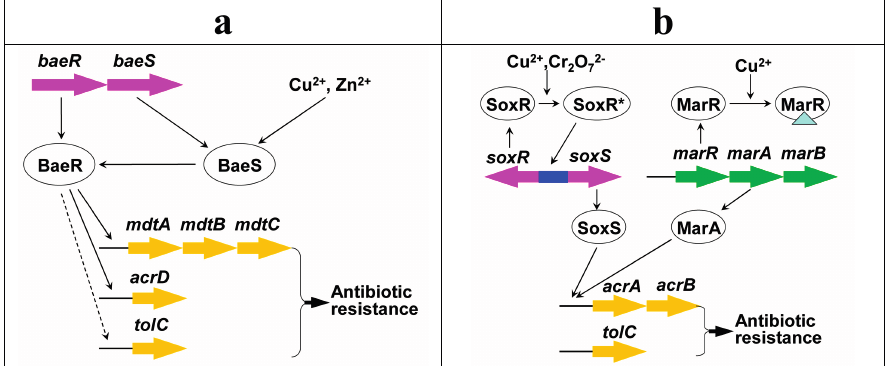
Figure 6. Possible mechanism (co-regulation) for heavy metal induced antibiotic resistance. ( a ) Pathway regulated by two-component signal transduction system BaeRS; ( b ) pathway regulated by global regulator SoxR or MarR. Identified or deduced pathways are represented as solid or dashed lines, respectively; the inducer of the repressor protein is represented as triangle; genes (gene clusters) are represented as colored arrows; * indicates the induced